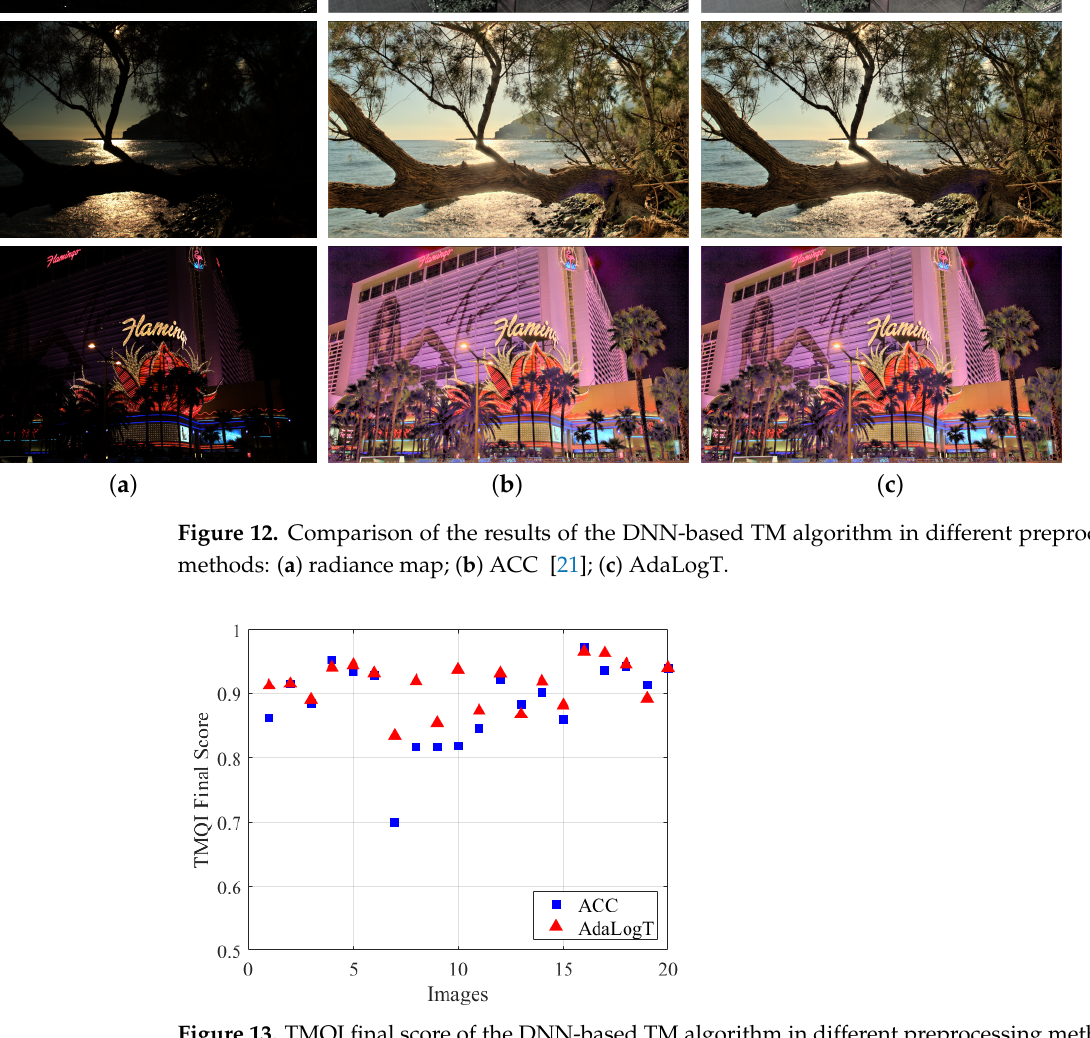
Figure 13. TMQI final score of the DNN-based TM algorithm in different preprocessing